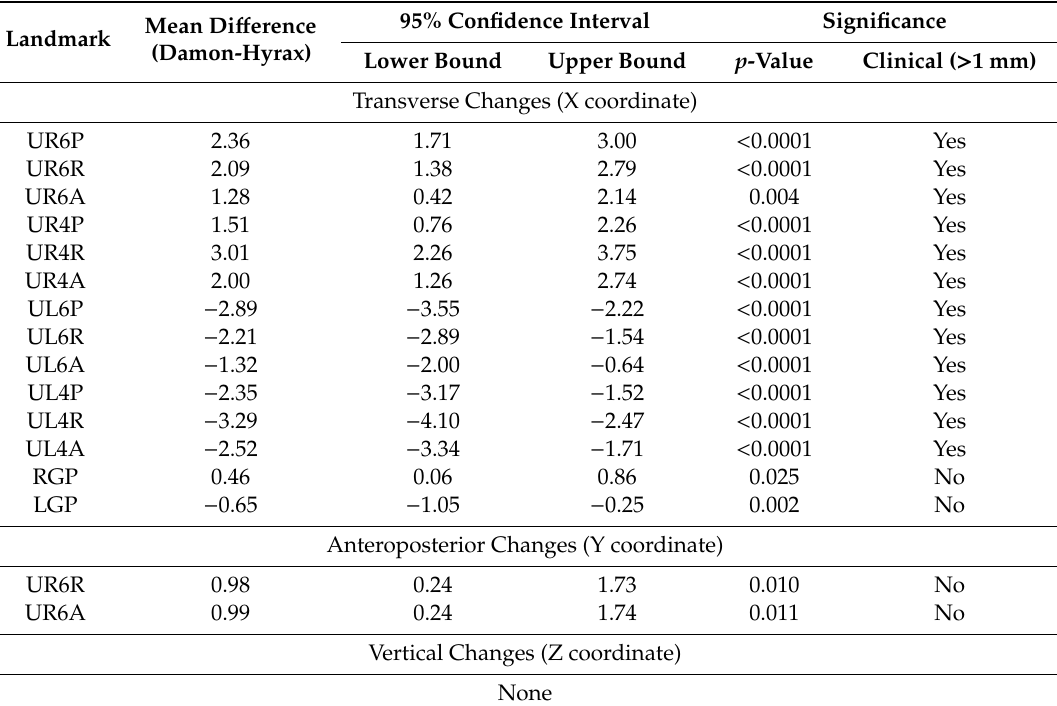
Table 4. Summary of statistically significant findings between treatment